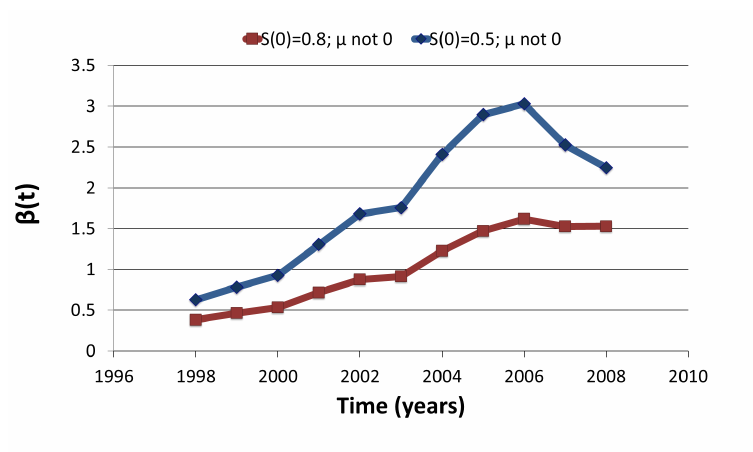
Figure 9. β ( t ) estimates of Obesity with initial (1997) prevalence of 19.5%.